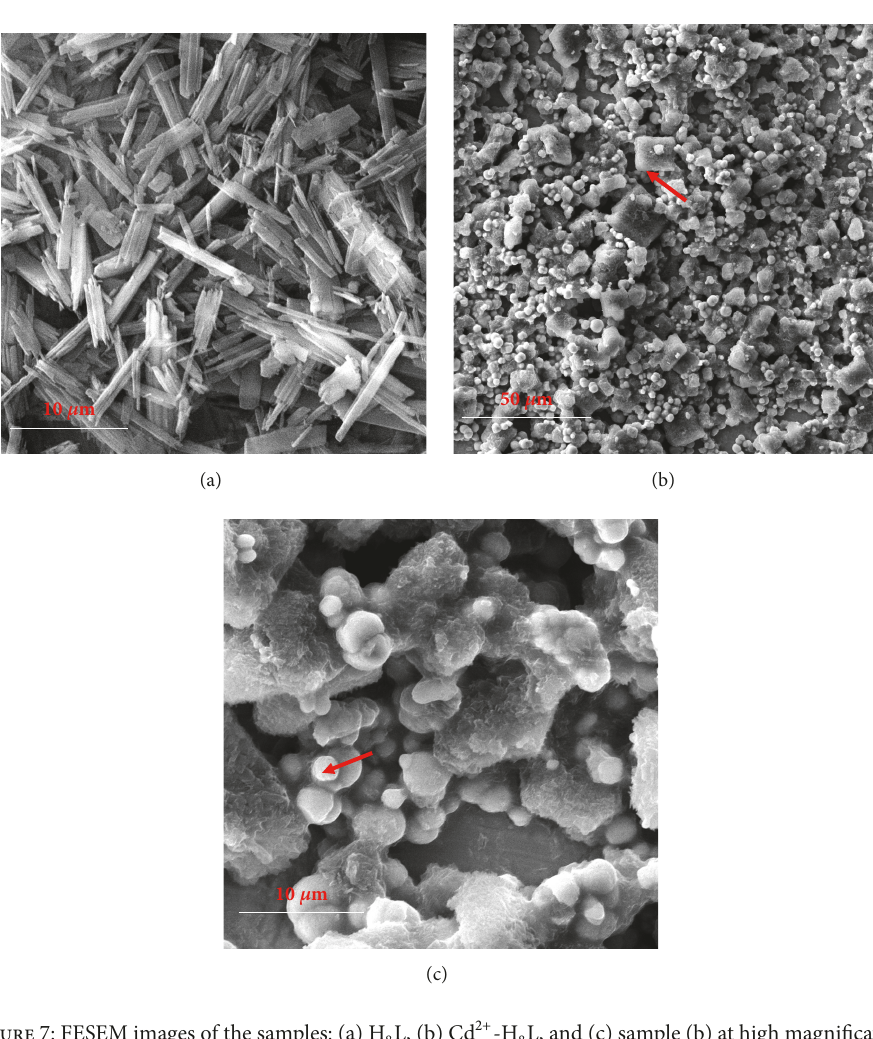
Figure 7: FESEM images of the samples: (a) H 8 L, (b) Cd 2+ -H 8 L, and (c) sample (b) at high magnification.